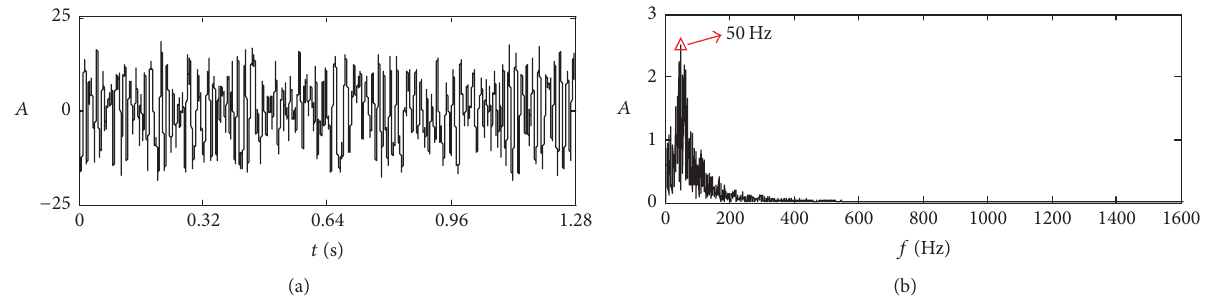
Figure 5: Detection result: (a) the output waveform of SR system; (b) the frequency spectrum of resonance